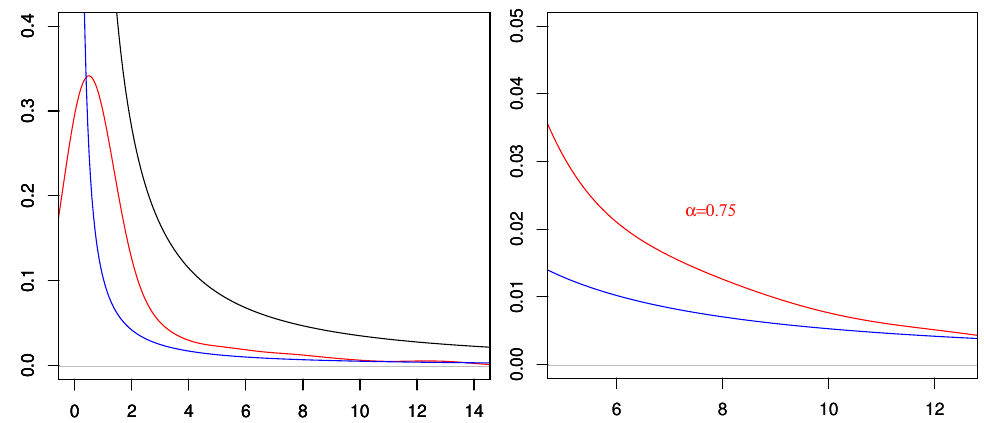
Figure 3. Case α = 0.75. Simulation details as in Figure 1. On the left , the red curve is simulated. The black curve is the plot of a ( t ) = S 1/6 · t − ( 3 + 2 α ) / ( 2 α + 2 ) with S = 0.1. The blue curve is then obtained as b ( t ) = c α · a ( t ) , with an estimated value of c α = 0.15. On the right , a zoom of the simulated density (red) and the approximation curve (blue), corresponding to those on the